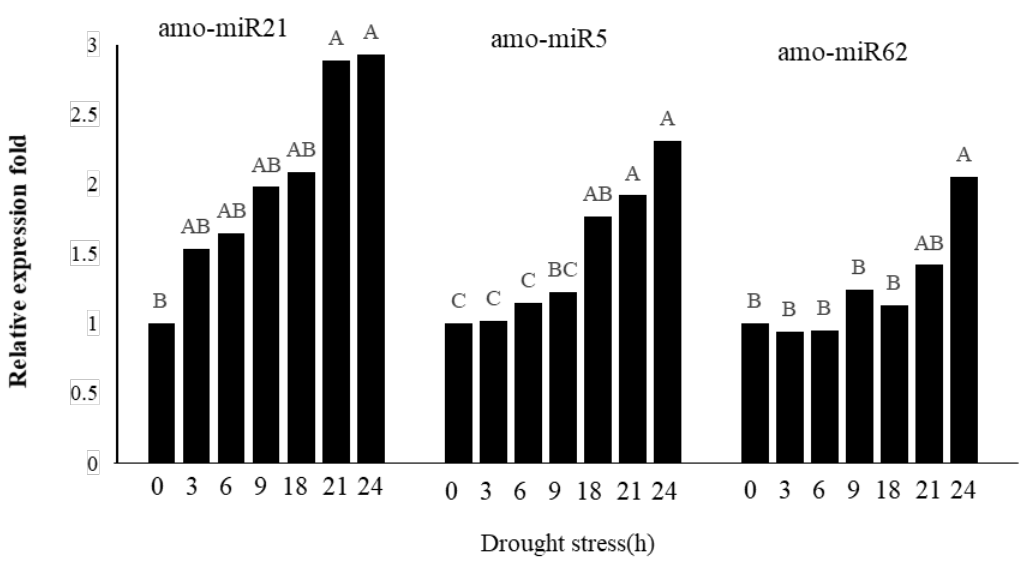
Figure 12. Relative expression level of miRNAs in transgenic Arabidopsis lines under 15% PEG treatment. Note: Different letters on the column indicate significant difference at 0.01 level.